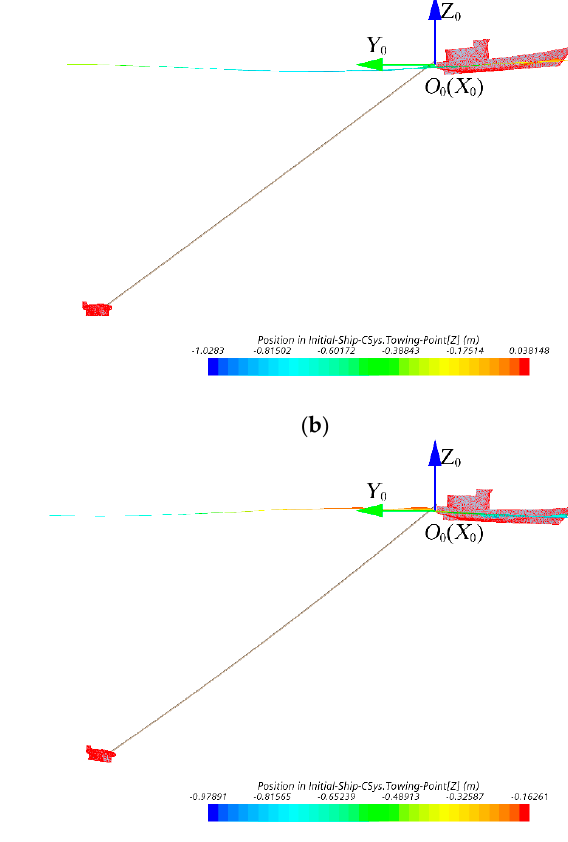
Figure 15. Time history of moment caused by the shifting weight.